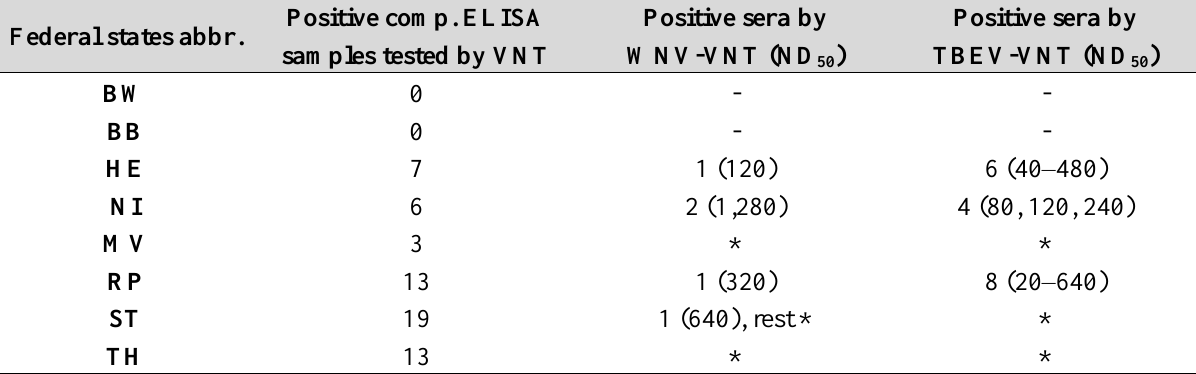
Table 3. Positive results by different VNT (neutralization titres in brackets). Federal states